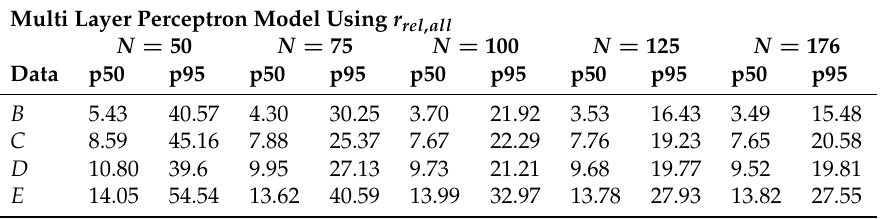
Table 9. 50 and 95 percentile of the error expressed in (cm) for the Multilayer Perceptron model for the second relative RSS